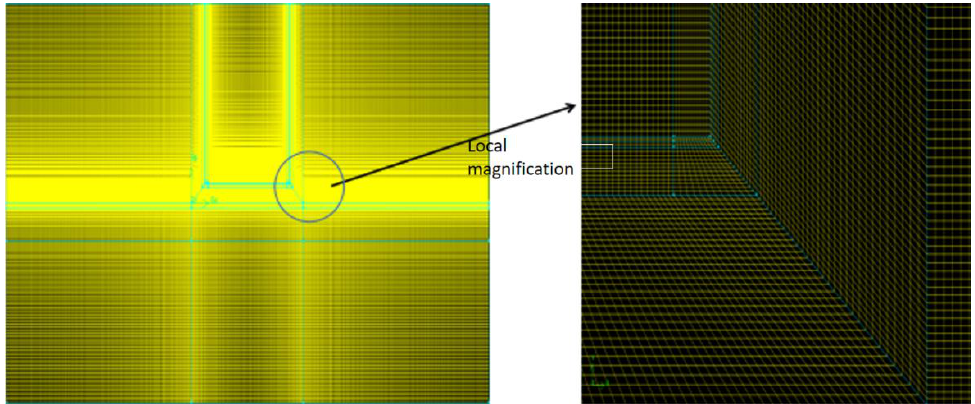
Figure 6. Computation grid of the numerical model.